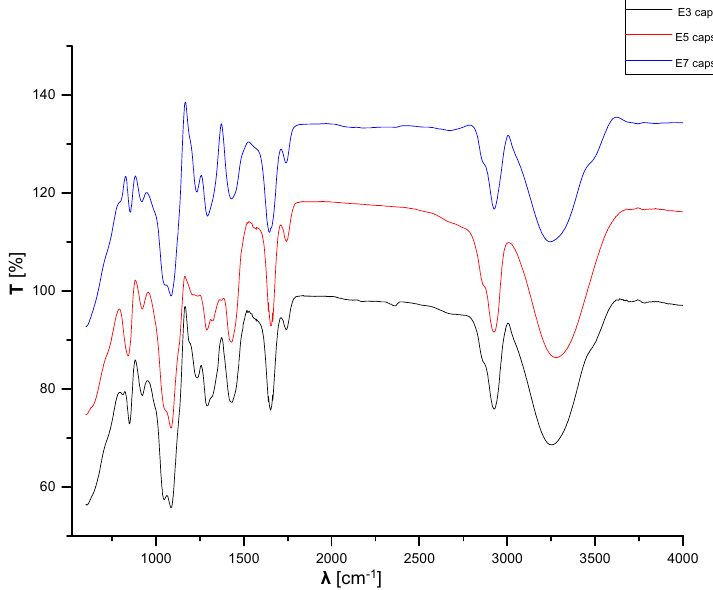
Figure 10. FTIR spectroscopy spectra of samples E3, E5, and E7.